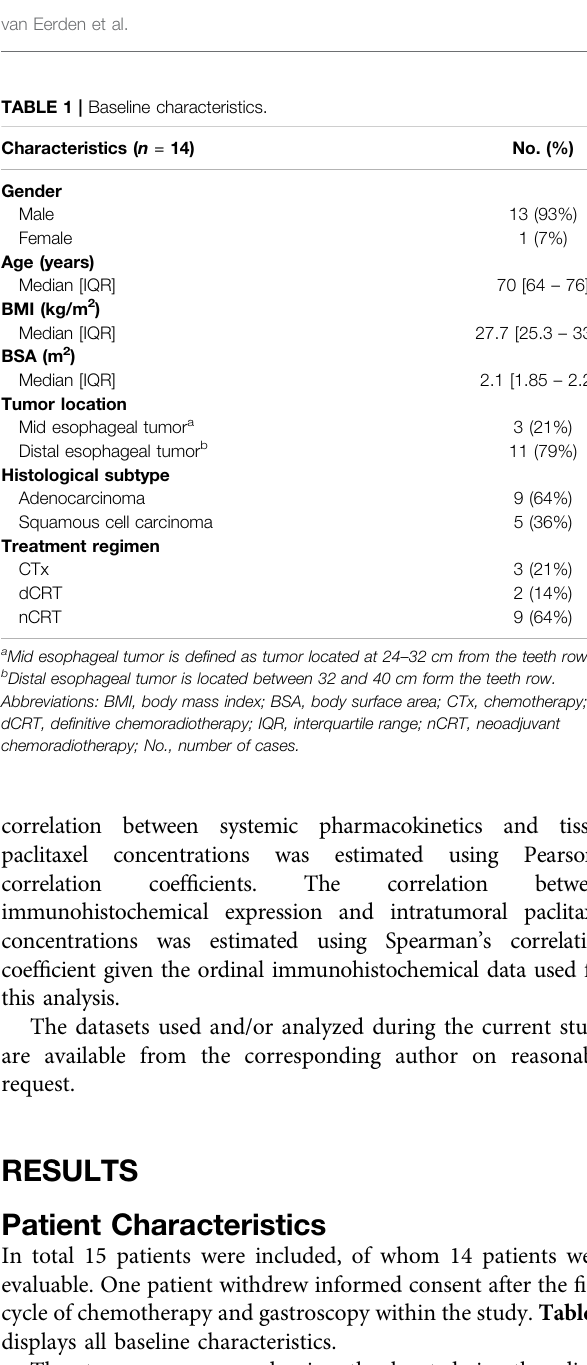
Table 2 ). The paclitaxel concentration in esophageal mucosa during the last cycle of chemotherapy (GEM: 1.89 ng/mg (95% CI: 1.26 – 2.85 ng/mg)) was not signi fi cantly different from the concentration measured during the fi rst cycle in esophageal